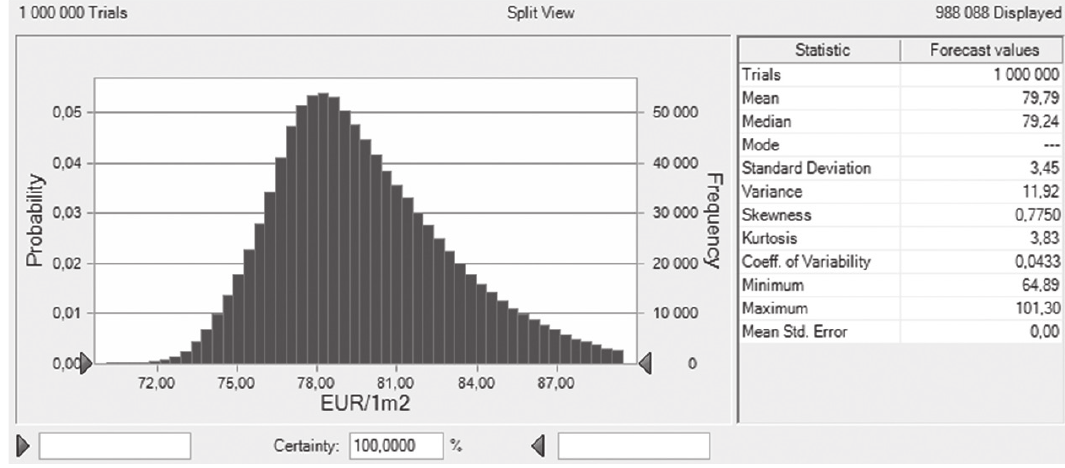
Figure 2. Market value distribution as an outcome of a simulation of the property valuation according to data from table